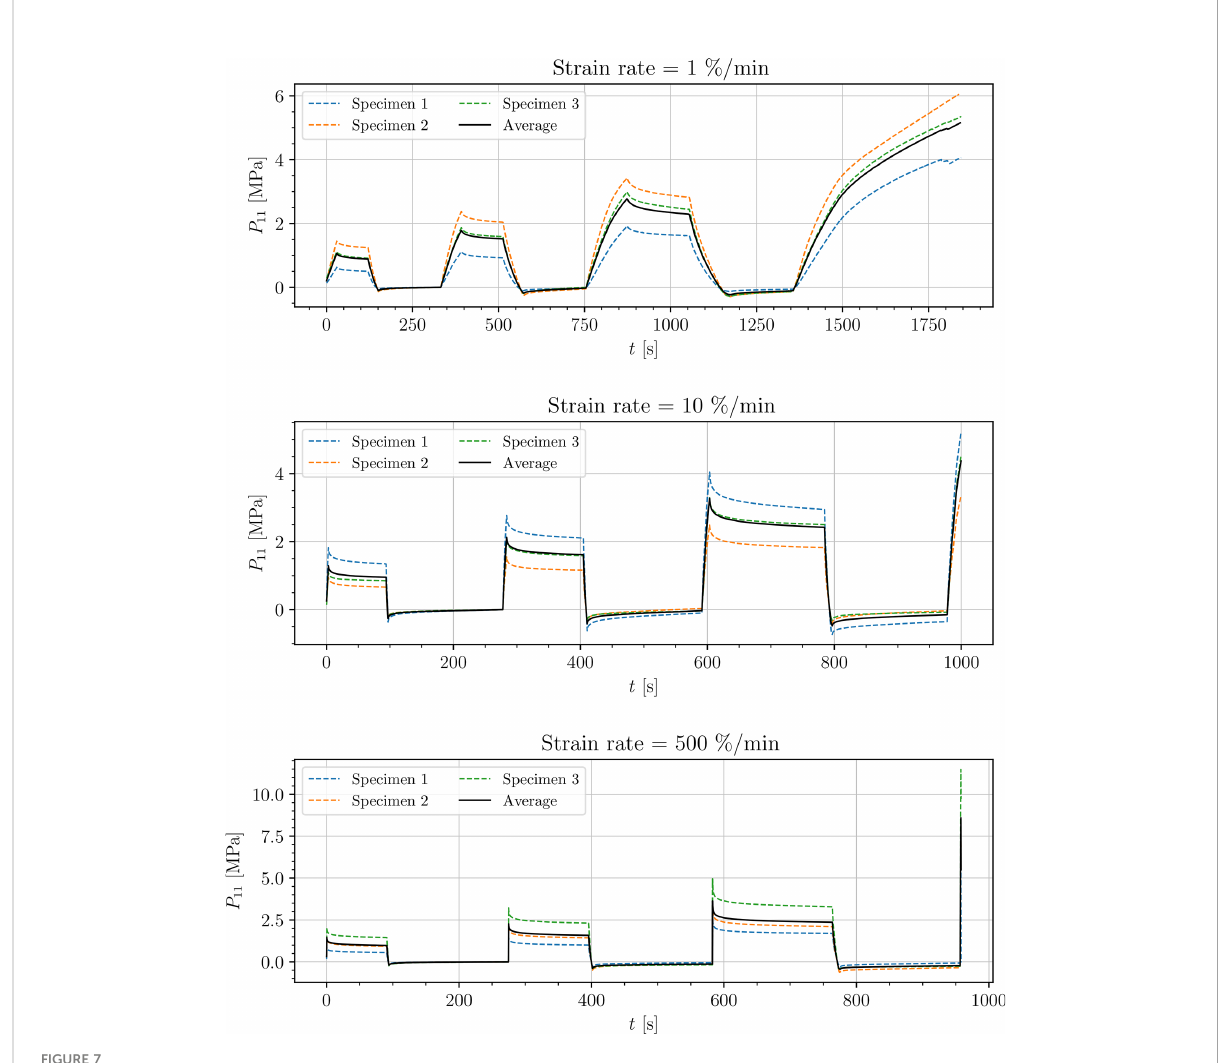
FIGURE 7 Uniaxial cyclic tensile stress-relaxation test of